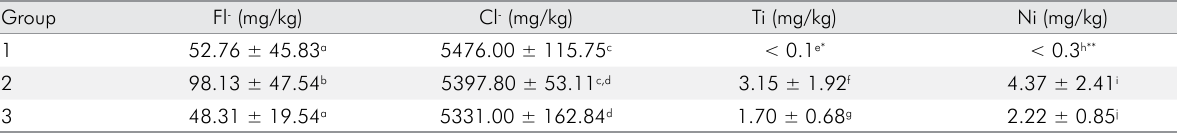
* Values represent the mean ± standard error (n = 10). Different letters indicate statistically significant differences between groups (p < 0.05). ** Quantification limit of the method. Group 1: [NaF 12 g/L + NaCl 1 g/L]; group 2: [NaF 12 g/L + NaCl 1 g/L + NiTi 0.50 g/L]; group 3: [NaF 6 g/L + NaCl 0.5 g/L + NiTi 0.25